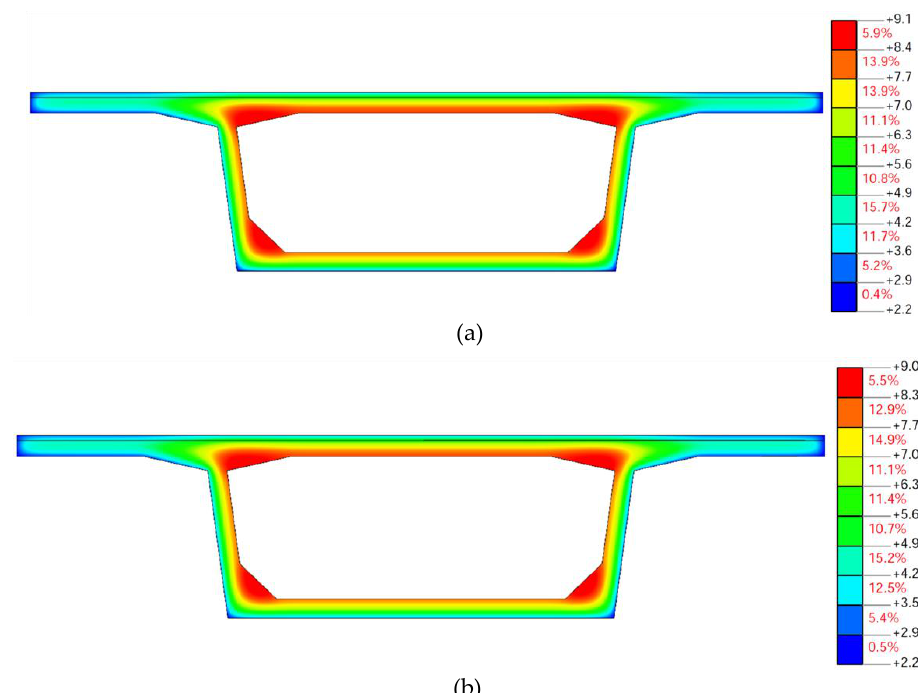
Figure 14. Temperature contour plots of box girder at 24:00 on 16 December 2010: ( a ) with solar radiation; and ( b ) without solar radiation.